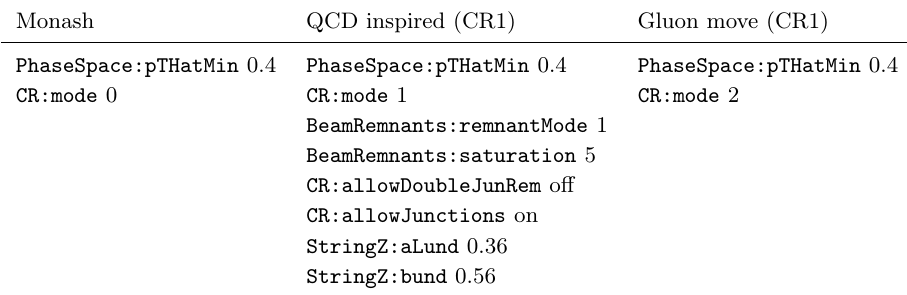
Table 6 . Settings for the different Pythia 8 productions. CR stands for Colour Reconnection. Pythia version 8.303 is